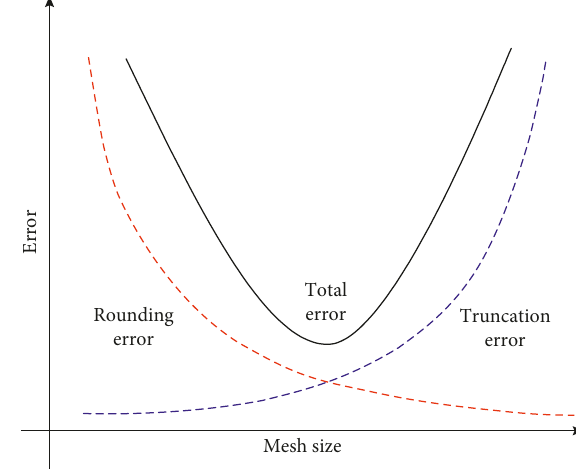
Figure 8: Mesh size and error